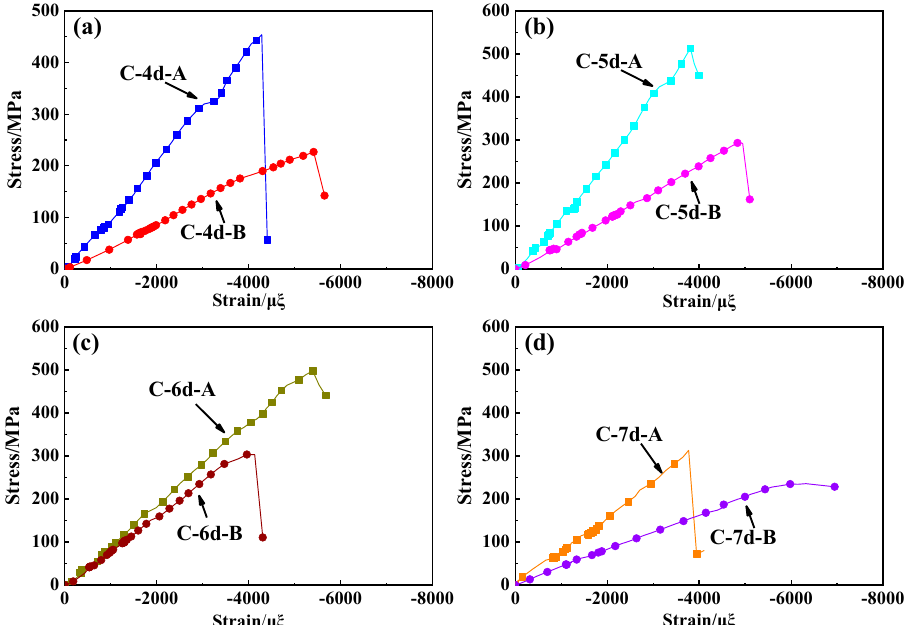
Figure 7. The compressive stress–strain curves of (a) 3D4dBC, (b) 3D5dBC, (c) 3D6dBC and (d) 3D7dBC.